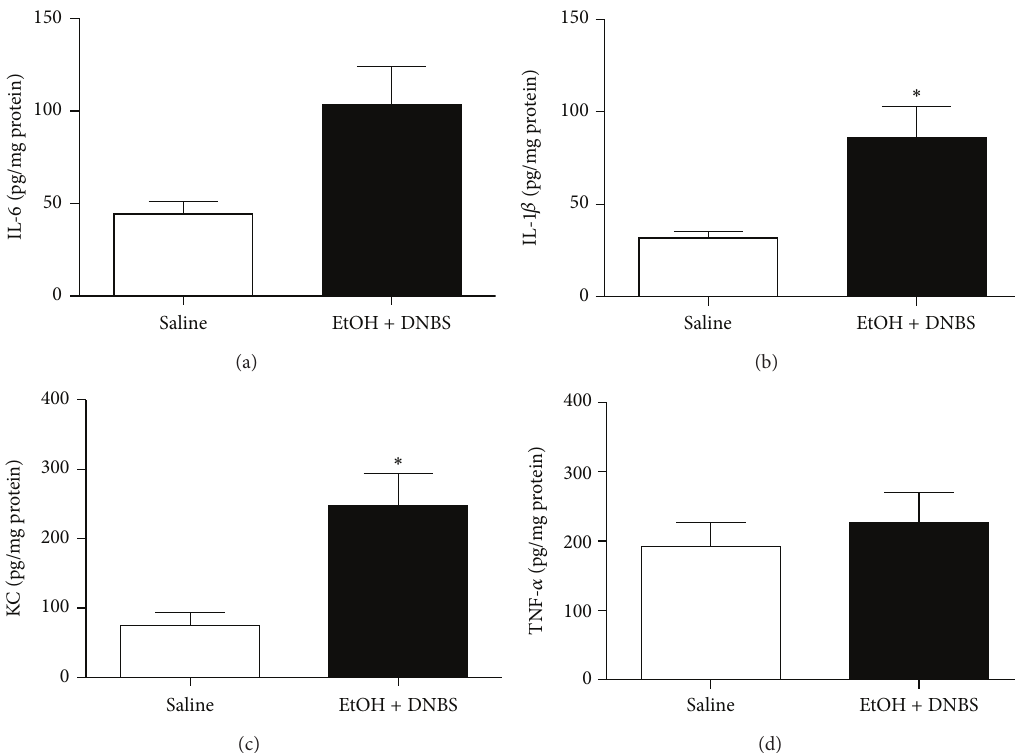
Figure 2: Cytokine production is elevated when ethanol + dinitrobenzene sulfonic acid is administered in wild-type mice. Prostates were treated with sterile saline (saline) or ethanol + dinitrobenzene sulfonic acid (EtOH + DNBS) for 2 days. The inflammatory response was measured by monitoring (a) interleukin-6 (IL-6), (b) interleukin-1 𝛽 (IL-1 𝛽 ), (c) keratinocyte-derived cytokine (KC), and (d) tumor necrosis factor- 𝛼 (TNF- 𝛼 ). Data are mean ± SEM of 𝑛 = 4 –6 per group. ∗ 𝑃 < 0.05 for EtOH + DNBS versus